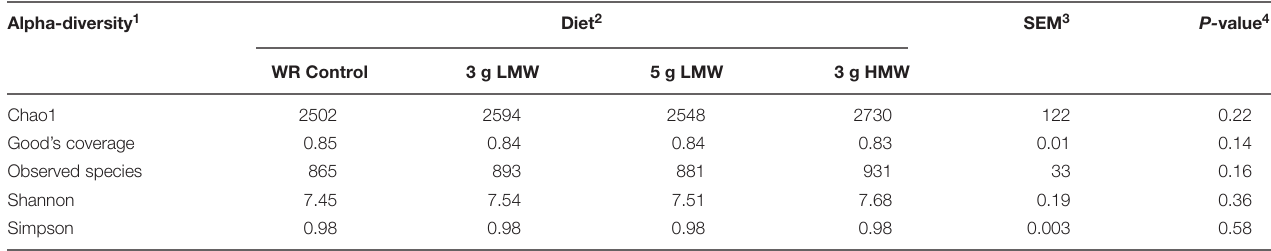
TABLE 1 | Biodiversity of microbial communities in feces affected by β -glucan